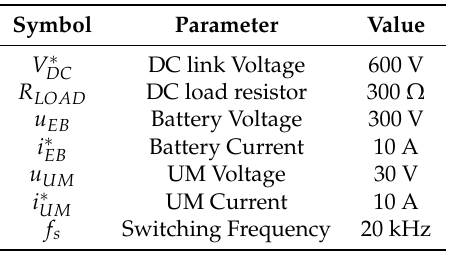
Figure 4. Experimental waveforms of the DPC scheme. Steady states: ( a ) i EB = 10 A, i UM = 10 A; and ( b ) i EB = 10 A, i UM steps from 1 A to − 1 A. Table 2. Operating parameters of the system under